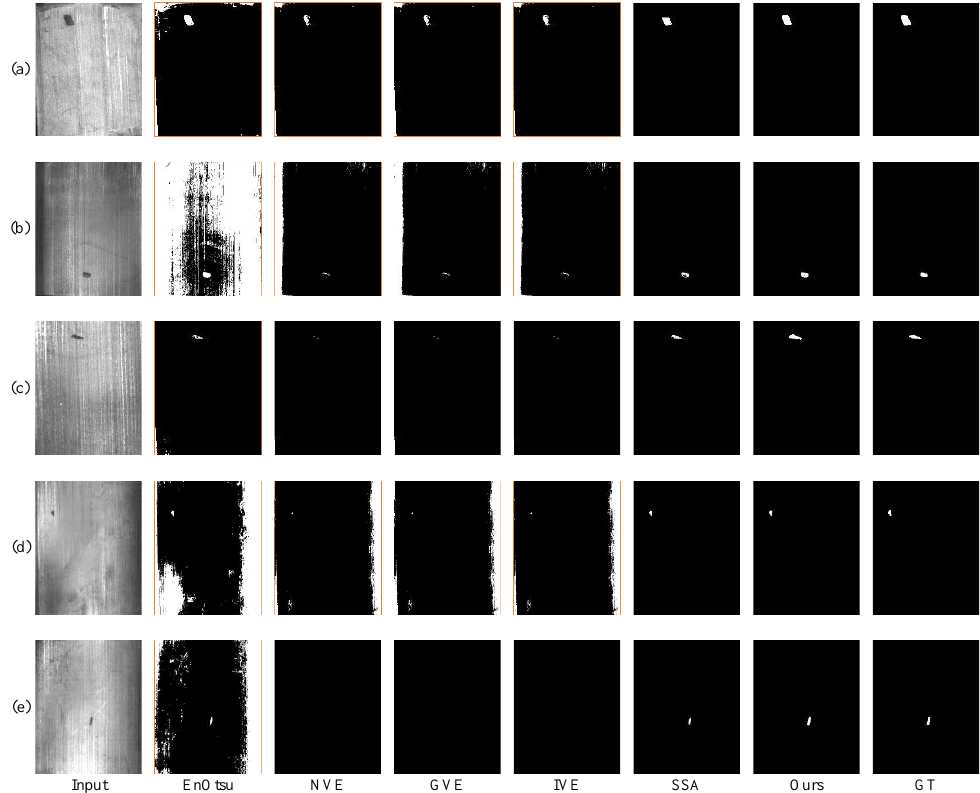
Figure 8. Result of different methods on ( a – e ) five magnetic tile images with a blowhole defect. Visual comparisons of detection results of the six methods on magnetic tile images with a blowhole defect. SSA and the proposed method (ours) are capable of identifying the defect